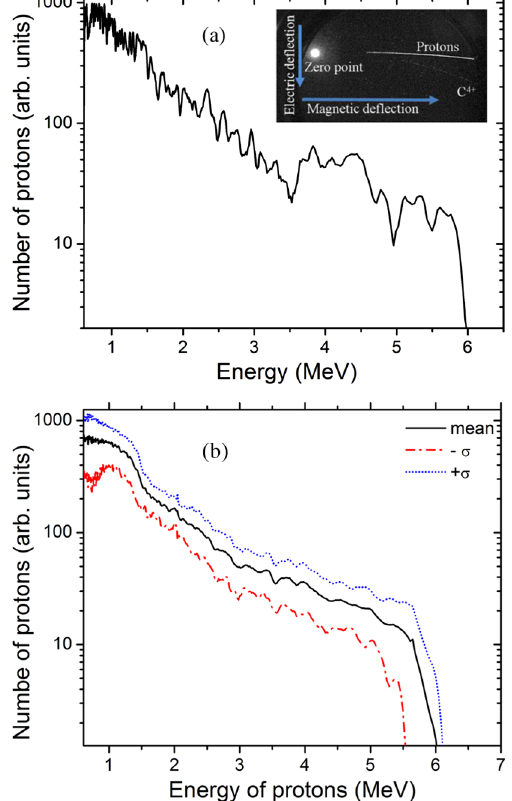
FIG. 5. Energy spectra of the accelerated protons. (a) Typical proton spectrum extracted from the raw images, shown in the inset, on the MCP detector, (b) Mean proton energy spectrum for 50 consecutive laser shots.